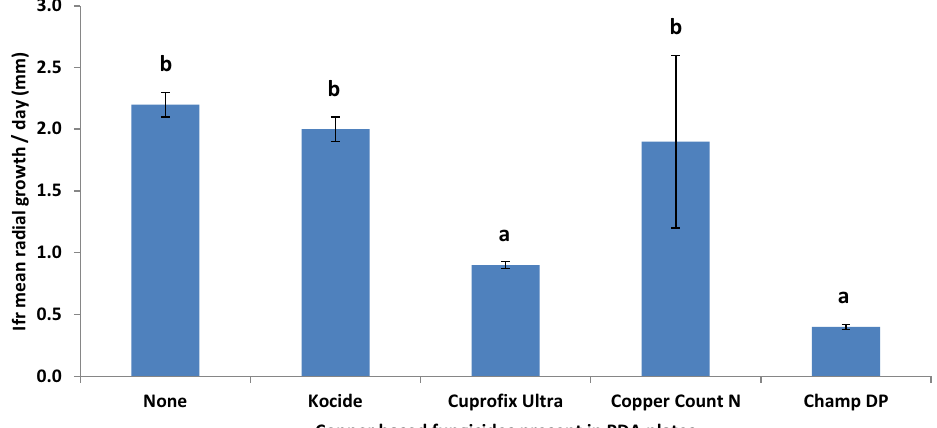
Figure 3. Effect of copper-based fungicides present in PDA plates on the radial growth of Isaria fumosorosea in vitro after 20 days post-inoculation. Data are mean ± SEM of two tests (10 replicates per test) and the letters above the bars indicate significance ( P < 0.05, Duncan's multiple range